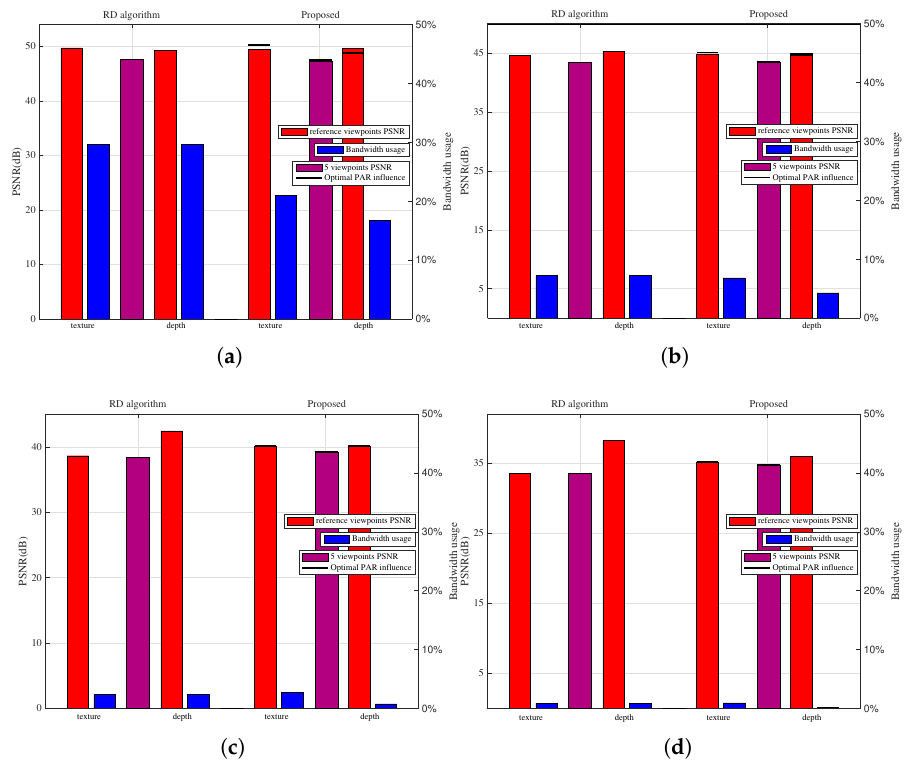
Figure 7. Bandwidth usage savings and PAR influence under SNR chk = 20 dB: ( a ) PSNR target = 50 dB; ( b ) PSNR target = 45 dB; ( c ) PSNR target = 40 dB; ( d ) PSNR target = 35 dB.